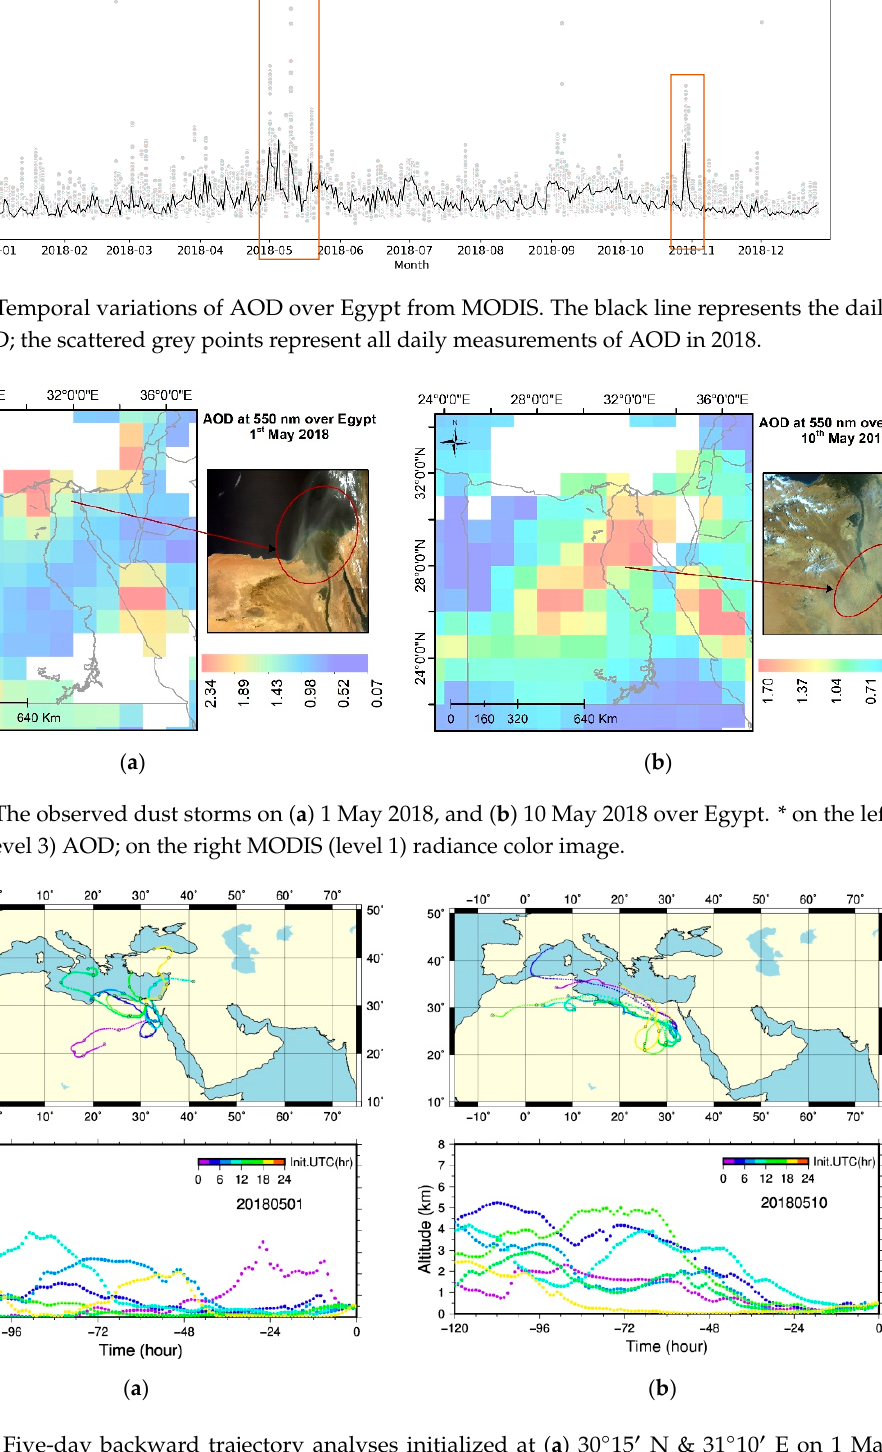
Figure 3. Temporal variations of AOD over Egypt from MODIS. The black line represents the daily mean AOD; the scattered grey points represent all daily measurements of AOD in 2018.